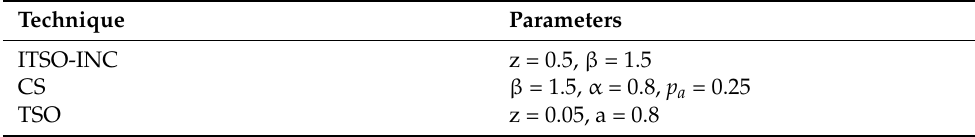
Table 7. The parameters used in this study.